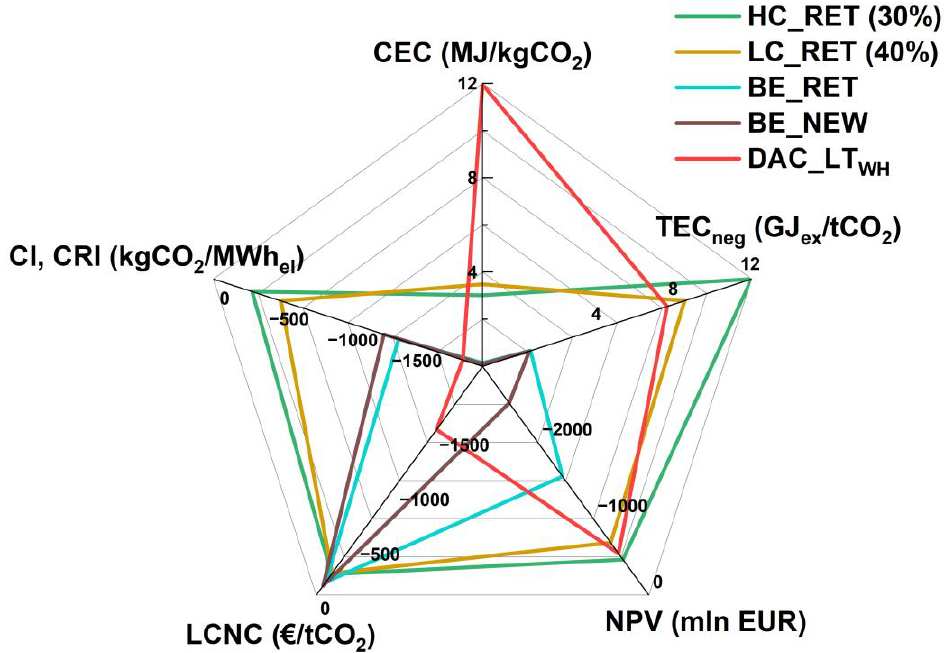
Figure 9. Summary of the analyzed cases.